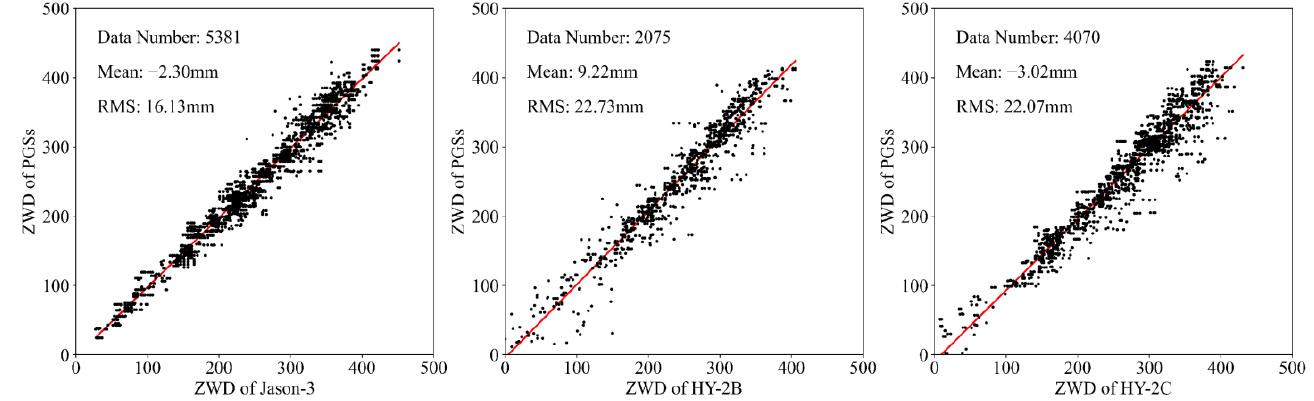
Figure 12. Validation results of the ZWD of altimeters. The Bias was MWR minus the PGSs.